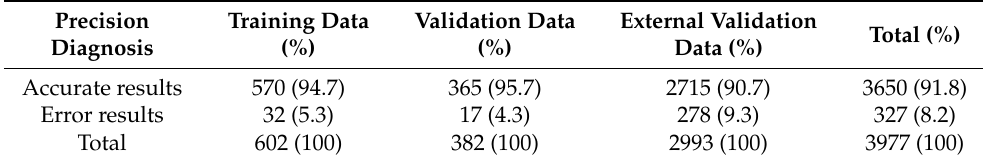
Table 3. A comparison of precision error rates for training, validation, and external validation datasets of lymphoma